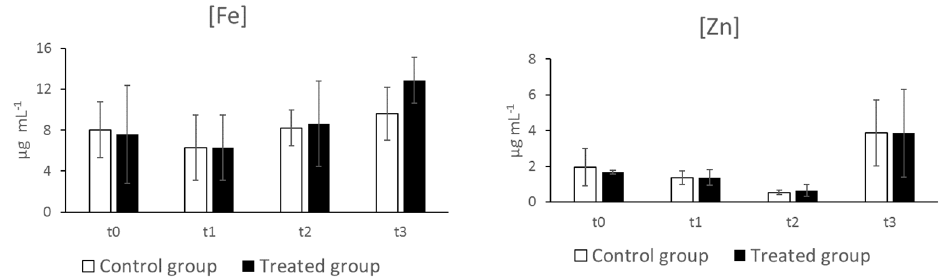
Figure 4. Iron (Fe) and zinc (Zn) concentrations in sera of control (C) and supplemented hens (T). Data are reported as mean ± SD (n = 8) and expressed as µg mL − 1 .